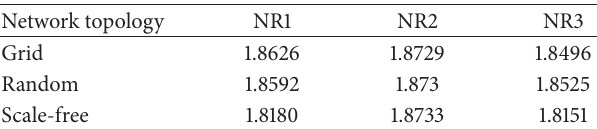
Figure 3: The different node recovery policies in the different network topologies. Table 9: The experiment results in different kinds of node recovery